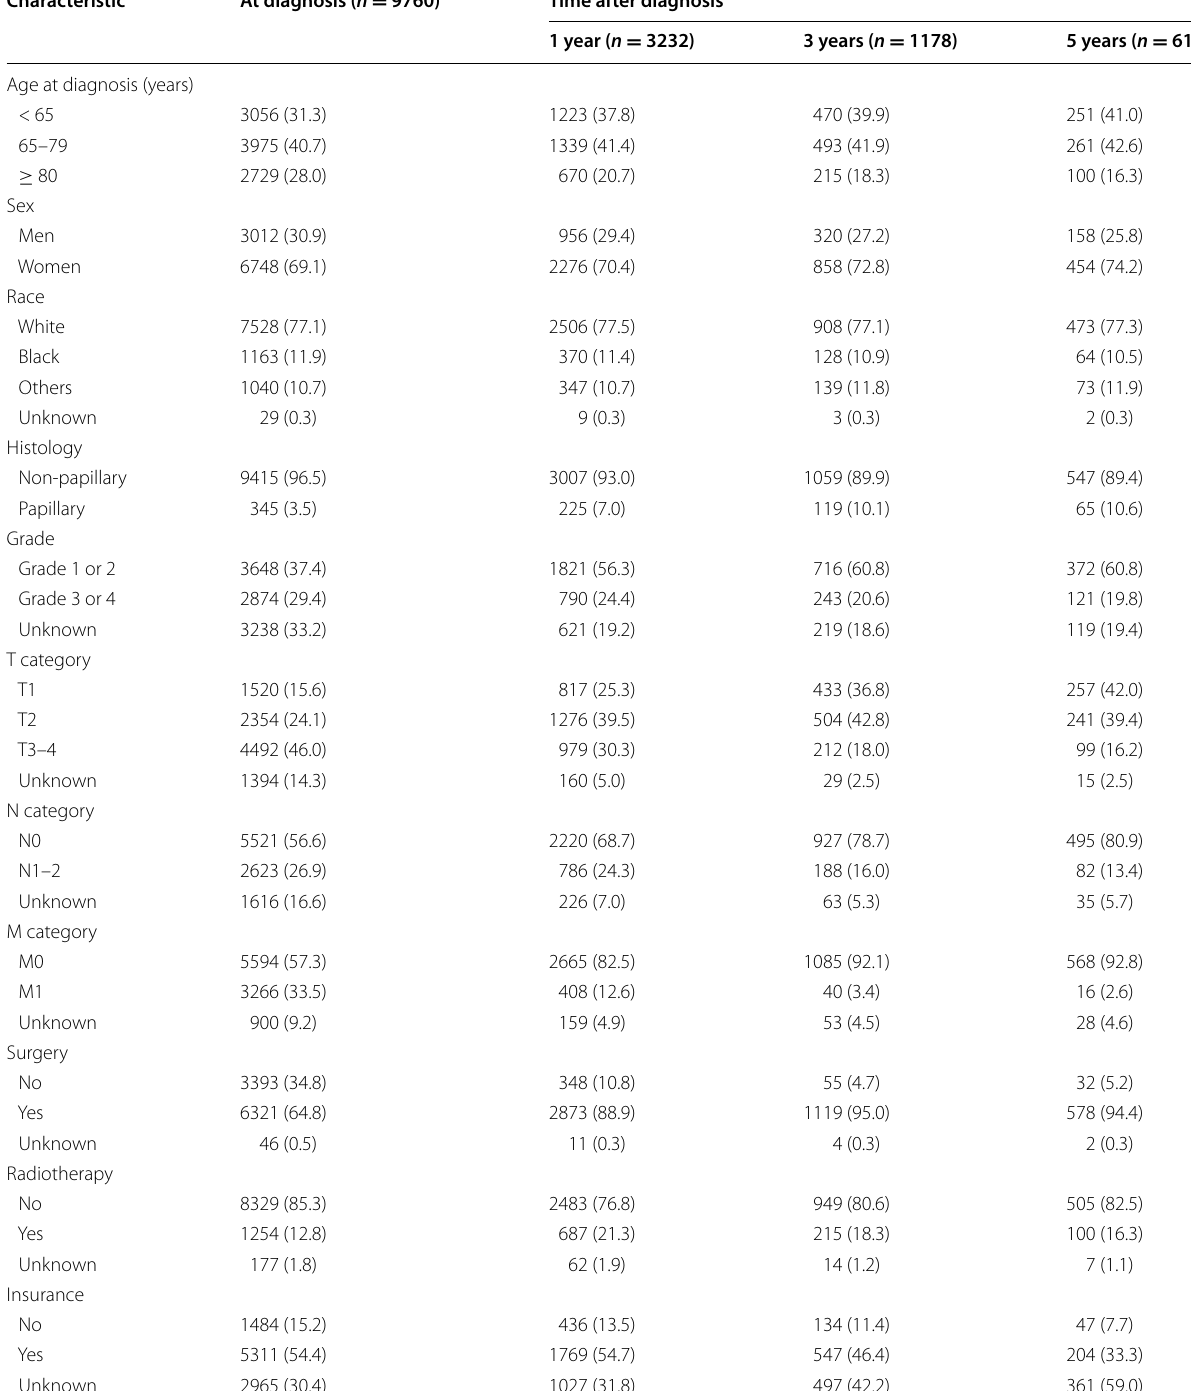
Table 1 Characteristics of patients with gallbladder cancer at the time of diagnosis and survivor characteristics at 1, 3, and 5 years after